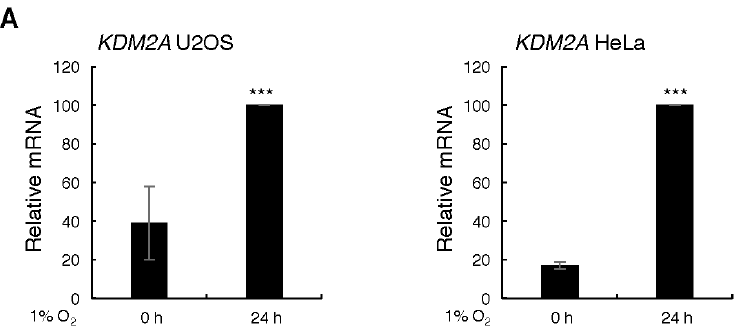
Figure 1. Cont. Figure 1.